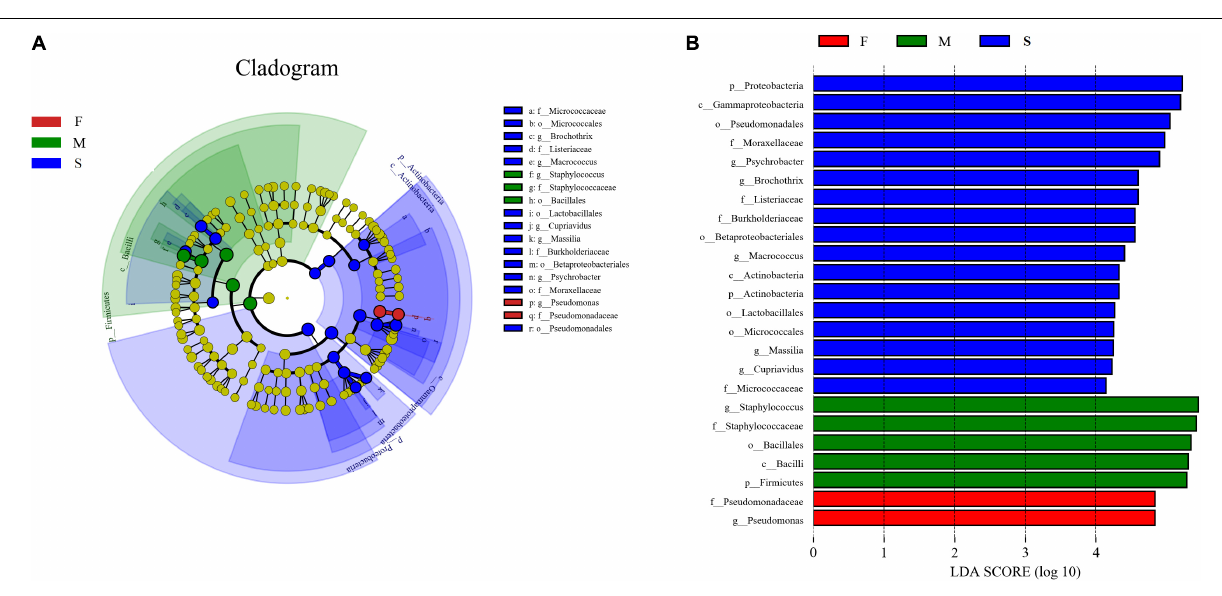
FIGURE 3 | Cladogram indicating the phylogenetic distribution of taxon associated with the three groups of bacon samples. Differences are represented in the color of the most abundant class. The diameter of each circle is proportional to the abundance of the taxon (A) ; histogram of differentially abundant features between groups (logarithmic LDA score ≥ 4.0 and p ≤ 0.05) (B)